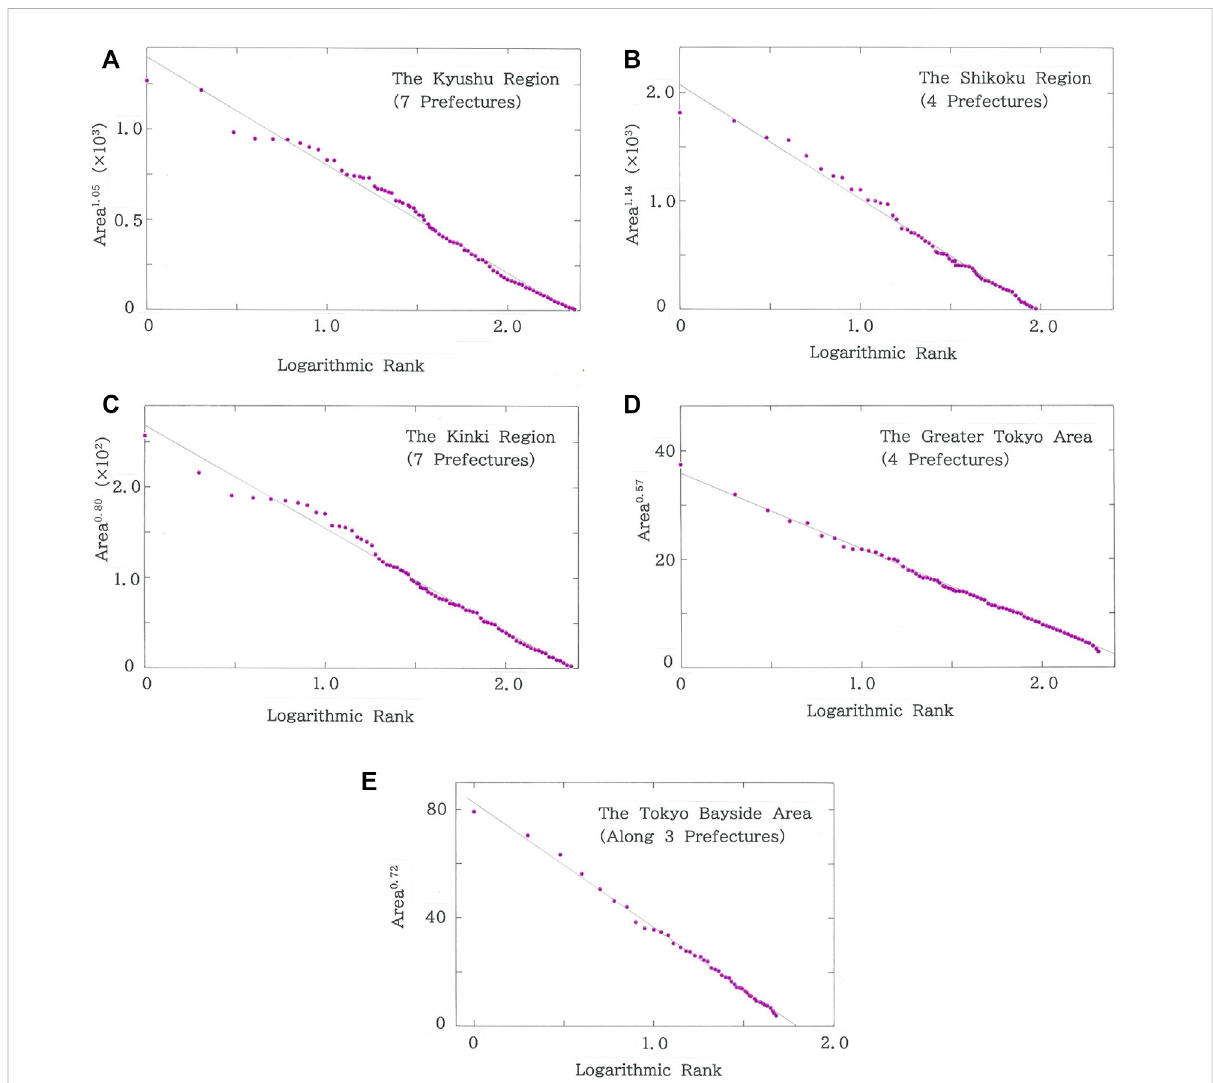
FIGURE 13 (A) Dependence of the areas (km 2 ) of municipalities in the Kyushu Region on the logarithmic rank. The brown declining line indicates the optimized fi t (| r | = 0.9947 with d = 0.321 for q = 1.05 and n = 233; a = 1.40×10 3 , b = 5.97×10 2 ). (B) Dependence of the areas (km 2 ) of municipalities in the Shikoku Region on the logarithmic rank. The brown line indicates the optimized fi t (| r | = 0.9951 with d = 0.614 for q = 1.14 and n = 95; a = 2.08×10 3 , b = 1.05×10 3 ). (C) Dependence of the areas (km 2 ) of municipalities in the Kinki Region on the logarithmic rank. The brown line indicates the optimized fi t (| r | = 0.9963 with d = 0.172 for q = 0.80 and n = 227; a = 2.68×10 2 , b = 1.13×10 2 ). (D) Dependence of the areas (km 2 ) of municipalities inthe Greater Tokyo Area(GTA) on the logarithmic rank. The brown line indicates the optimized fi t (| r | = 0.9988 with d = 0.492 for q